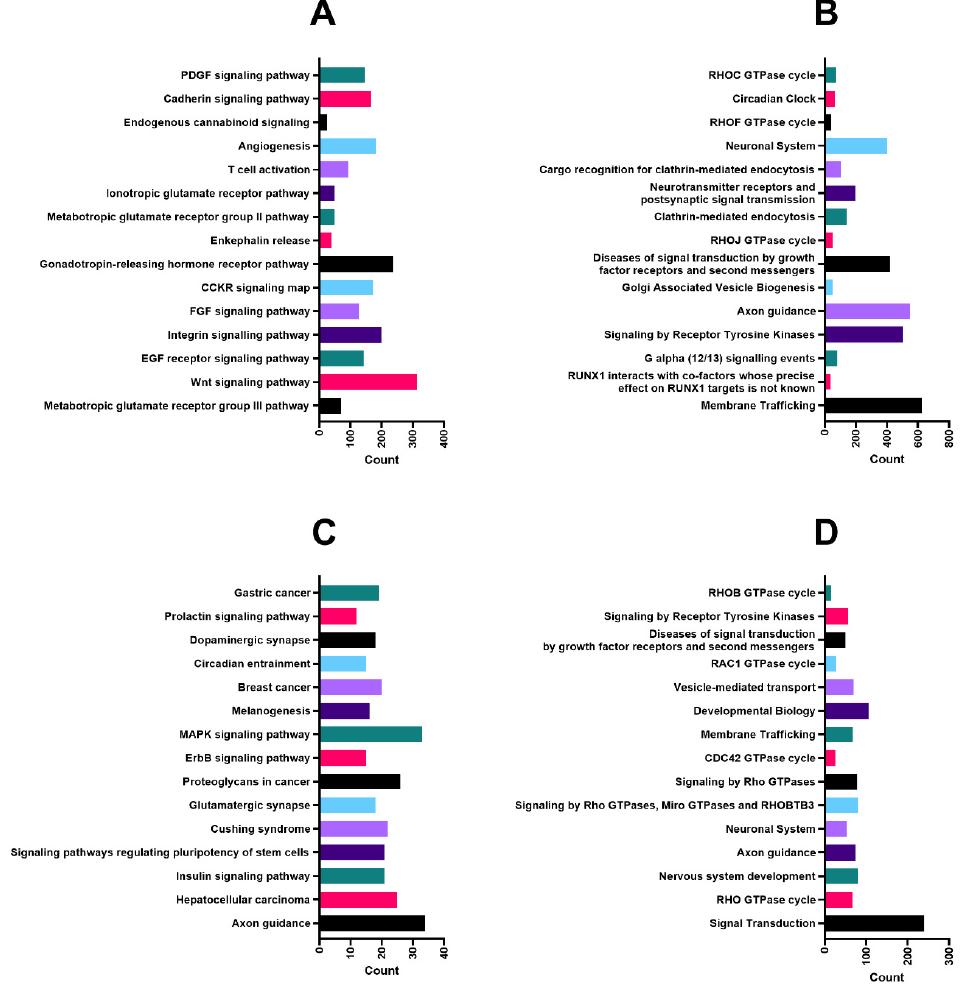
Figure 6. Functional annotation analysis of predicted targets of miR-218-5p, miR-31-5p and miR-199a-5p. PANTHER pathways ( A ) and Reactome pathways ( B ) with functional annotation provided by PANTHER annotation tool; KEGG pathway ( C ) and Reactome pathway ( D ) with functional an- notation provided by DAVID annotation tool. Top 15 most significantly ( p < 0.05) enriched terms are presented as count of genes per annotation.